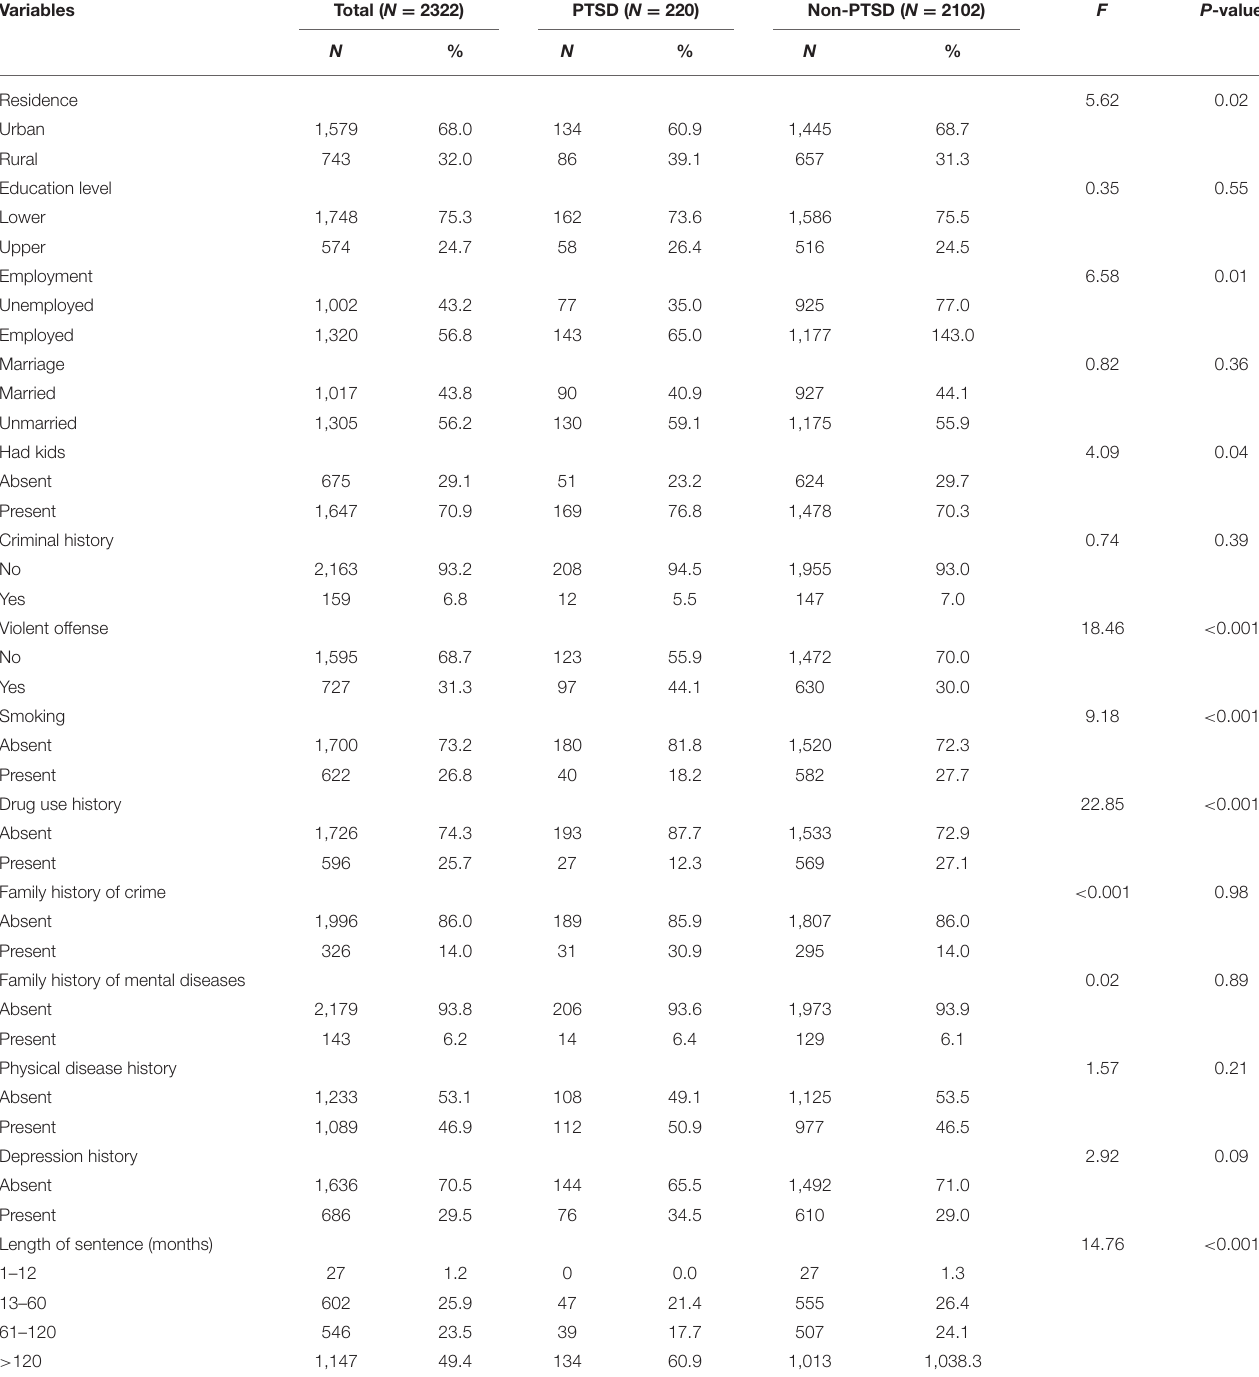
TABLE 1 | Socio-demographics, clinical, and criminological characteristics among incarcerated women.